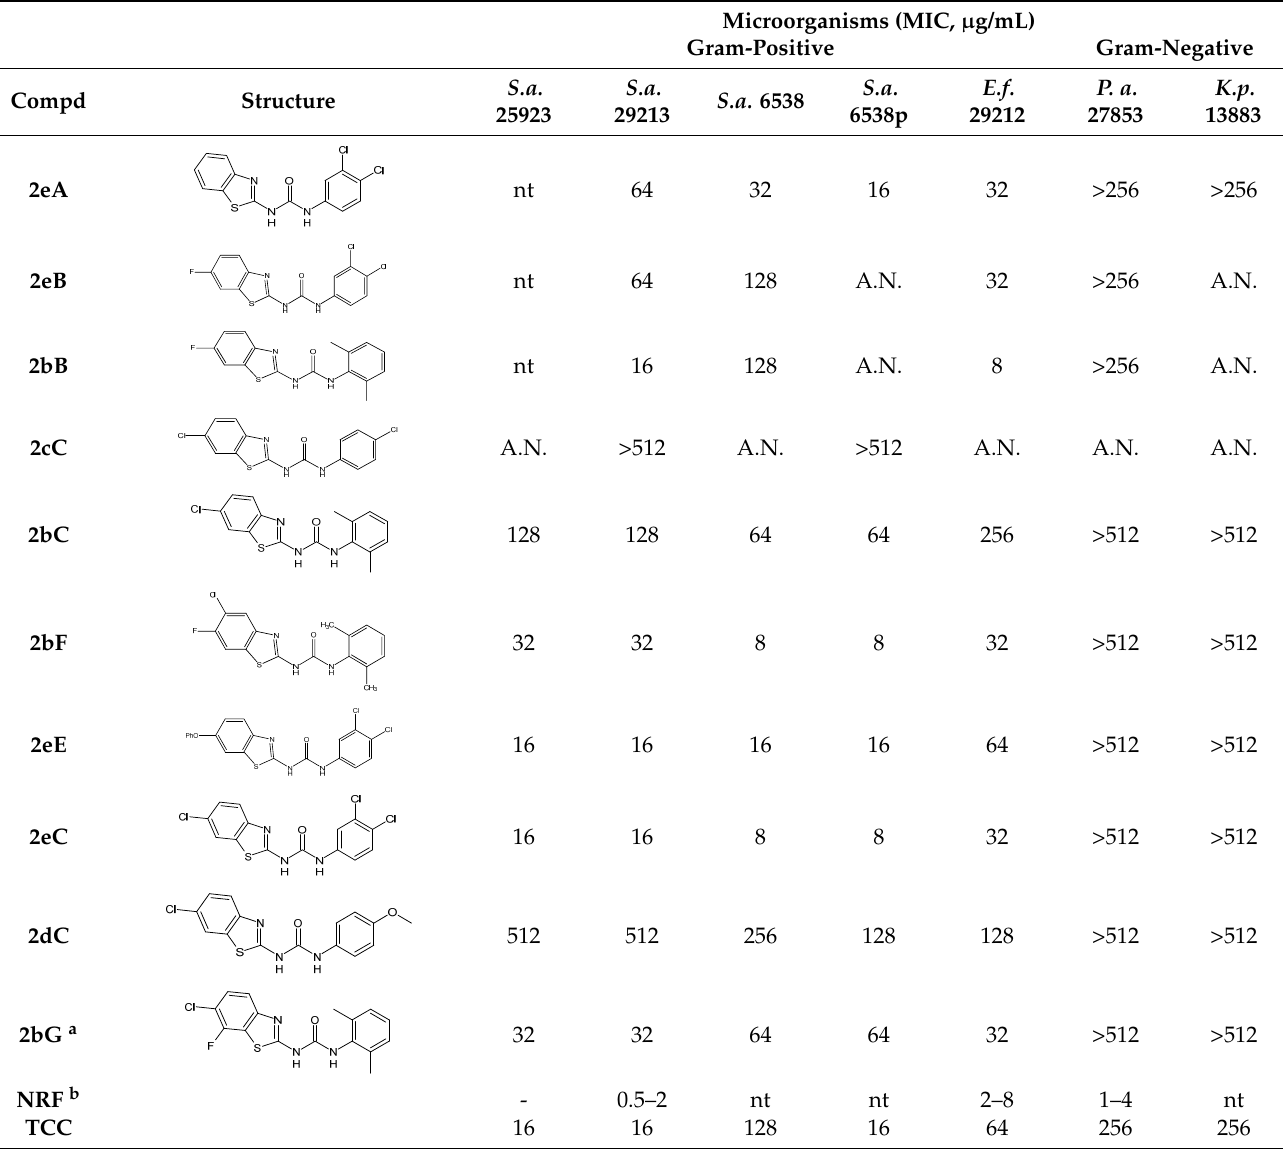
Table 1. Antibacterial activity of diarylureas.